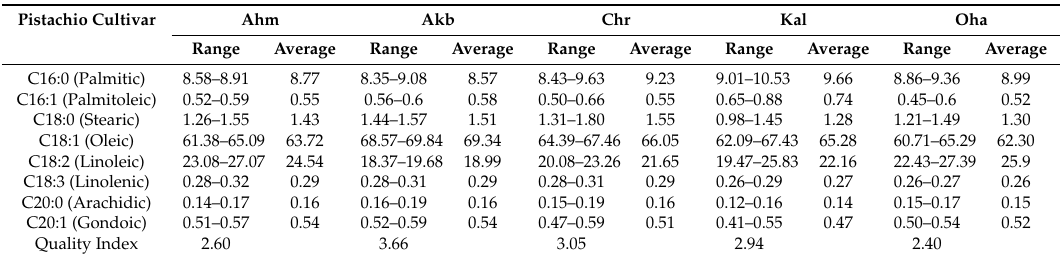
Table 2. The range and average values of the fatty acid composition (%) of pistachio oils of different